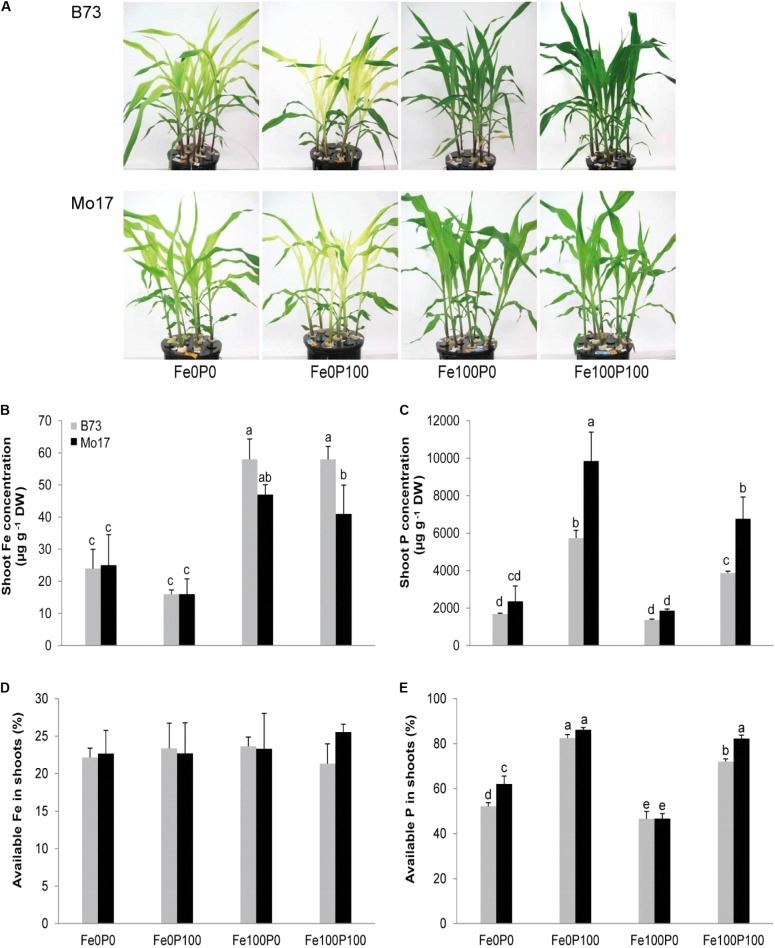
Shoot growth and nutrient concentrations as affected by Fe and P nutritional regimes in B73 and Mo17. (A) Shoot phenotype and concentrations of (B) Fe, (C) P, (D), and proportion of available Fe or (E) available P in shoots of B73 and Mo17. Plants were grown for 15 days in nutrient solution supplemented without Fe and P (Fe0P0), without Fe and with 100 μM P (Fe0P100), with 100 μM Fe and without P (Fe100P0) or with 100 μM Fe and 100 μM P (Fe100P100). Fe and P treatments were initiated after one week of preculture on full nutrient solution. Bars indicate mean values ± SD, n = 5. Different letters denote significant differences at p < 0.05.